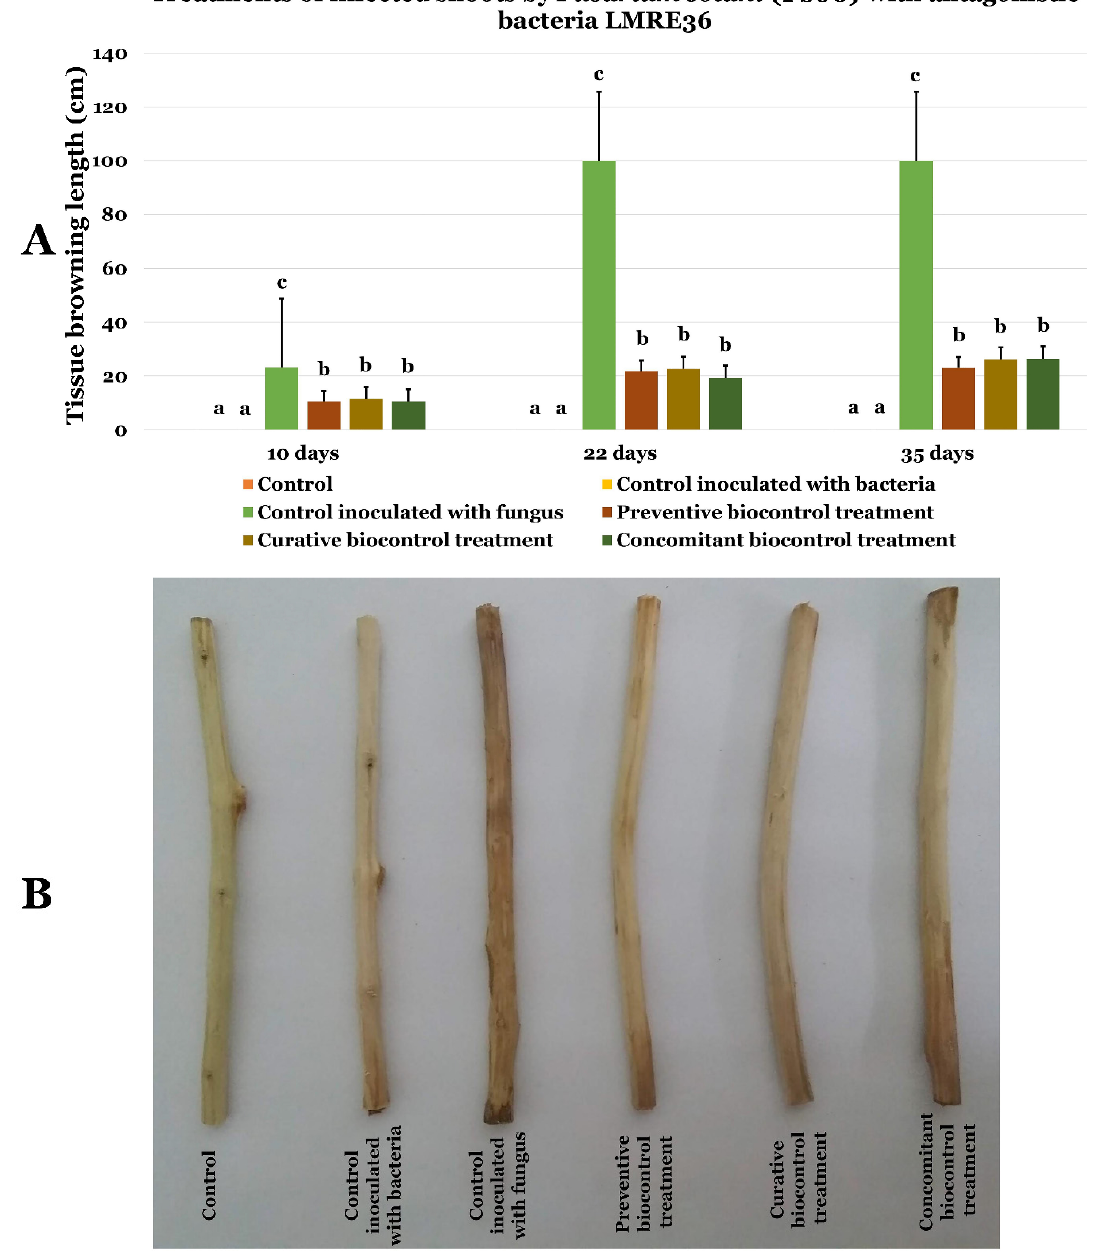
Figure 13. ( A ) Effects of LMRE 36 bacterial isolates on Fusarium solani strain Fso6 on olive tree shoots rot severity as compared to controls. ( B ) Effect of preventive, concomitant, and curative biocontrol treatment on olive tree shoots at 10, 22 and 35-days post-inoculation with Fusarium solani strain Fso6. Data presents mean ± standard error. Bars labelled with di ff erent letters are significantly di ff erent among the treatments at p < 0.05 using Tukey’s HSD